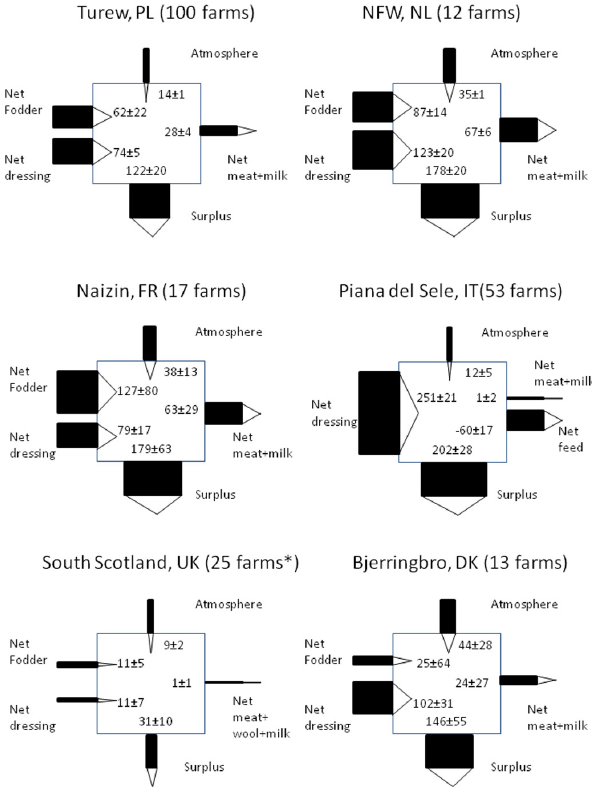
Fig. 4. N surpluses (kg N ha − 1 yr − 1 ) for each of the six landscapes, partitioned into the Fig. 3 components of the N balance, including N fixed or deposited from the atmosphere, net N fodder import (or feed export if negative), net import of dressing in the form of fertilis- ers or manure, and the net export of milk and meat, also including N in eggs and wool (all with 95% confidence intervals under the assumption of a normal distribution). (*) excluding landless poultry farming in Scotland. If the landless poultry farming was included, the UK N-surplus would be similar to PL and DK, but with a much larger fodder import of around 300–400kg N ha − 1 yr − 1 , a net ma- nure export of around 150–200kg N ha − 1 yr − 1 and a net export of eggs, meat, wool and milk of around 120kg N ha − 1 yr − 1